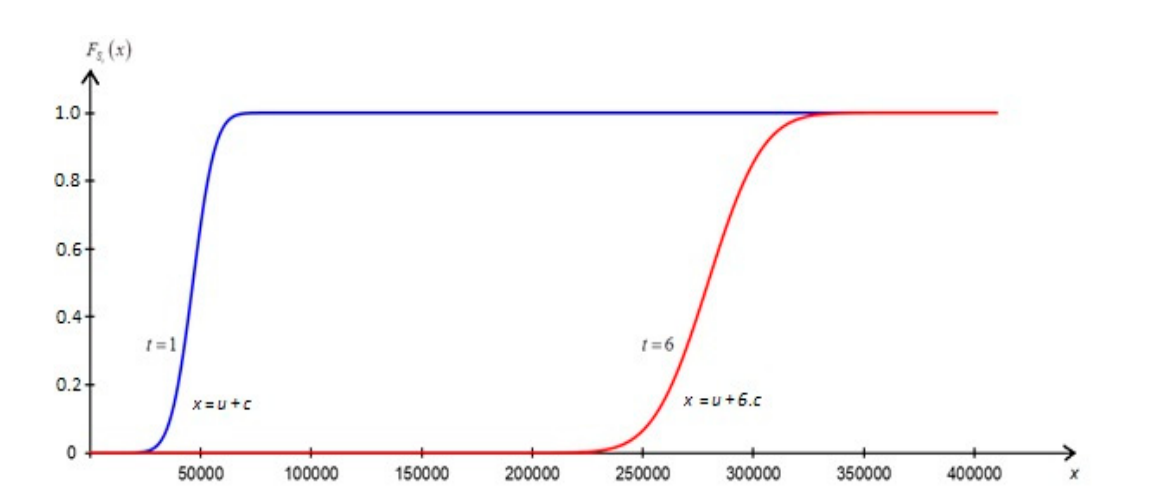
Figure 3. Relationship between the initial reserves u and a ruin probability of 0.01 at time t = 1 and t = 6 expressed by means of the distribution function.